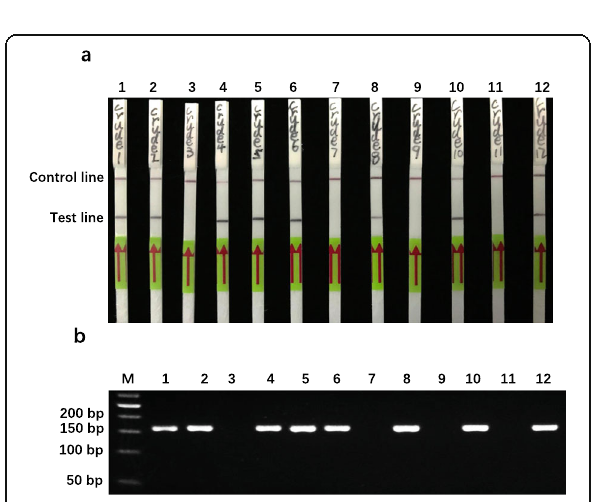
Fig. 6 Detection of BCMV in crude plant extracts by RPA-LFD. a RPA-LFD assay using crude sample extracts of soybean samples in the field, which were suspected to be BCMV-infected. b RT-PCR assay using purified RNA extracts from corresponding samples in